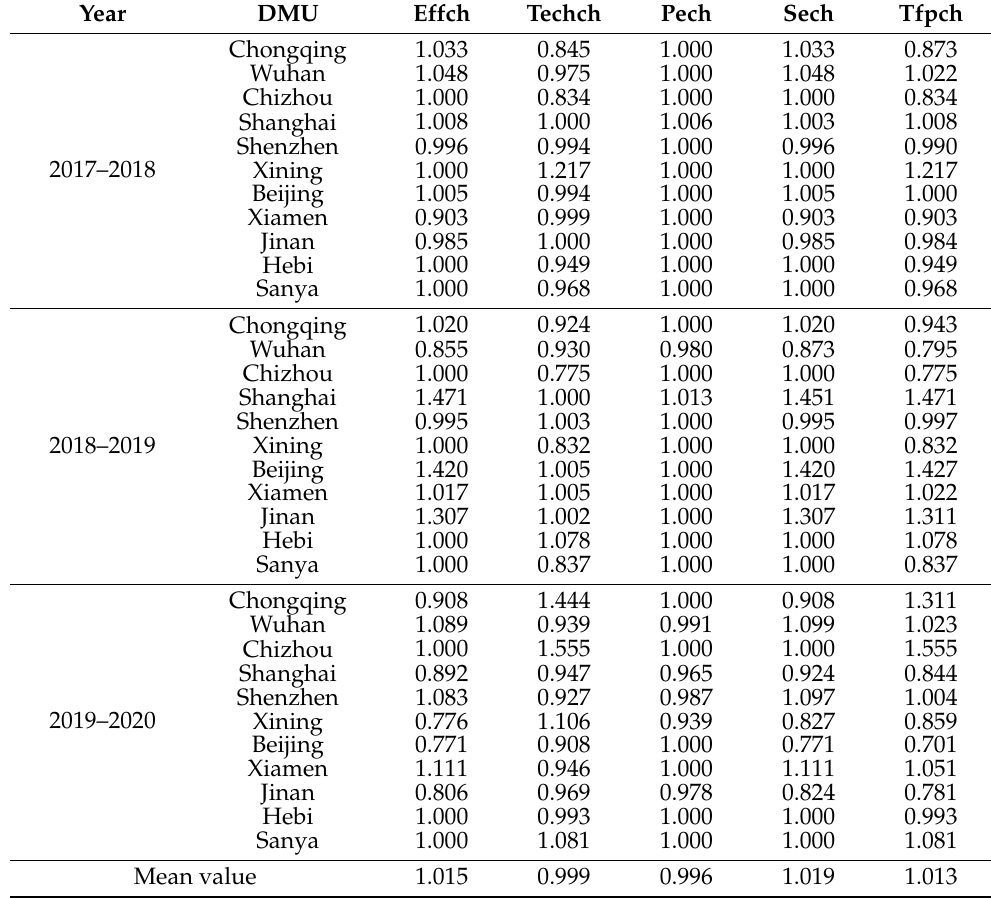
Table 5. Malmquist index of pilots from 2017 to